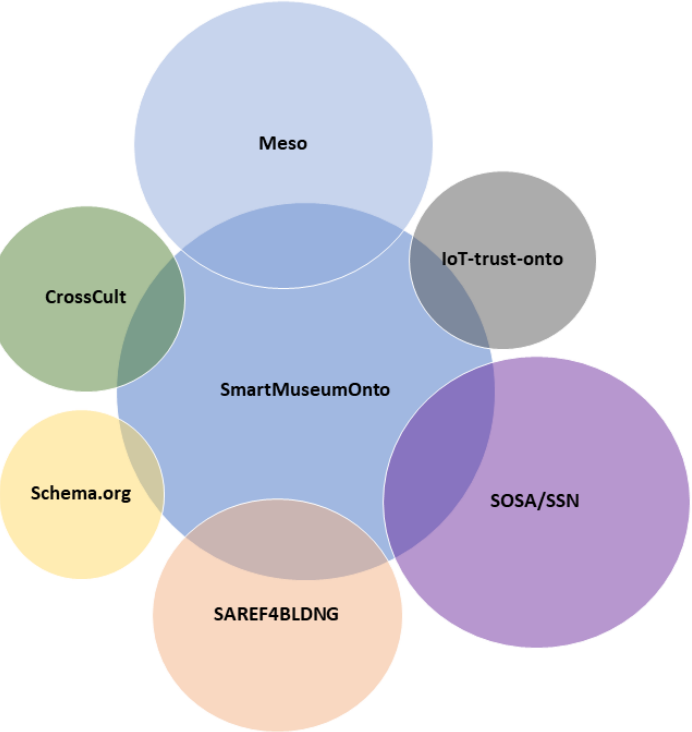
Figure 3. SmartMuseumOnto and the reused ontologies. The size of the circles indicates the percent- age of reused